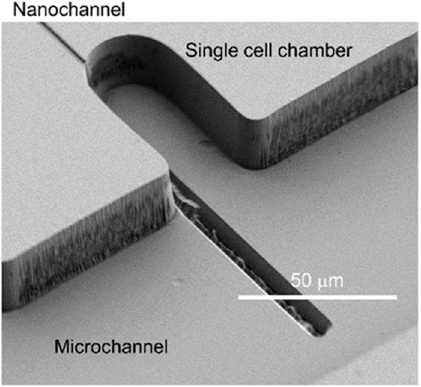
Figure 7. SEM image of the fabricated nanochannel, single cell chamber and microchannel.